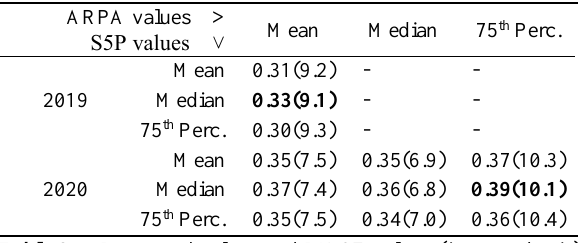
Table 3. R-squared values and RMSE values (in parenthesis) for values from station coordinates. Bold values are the highest r-squared values.